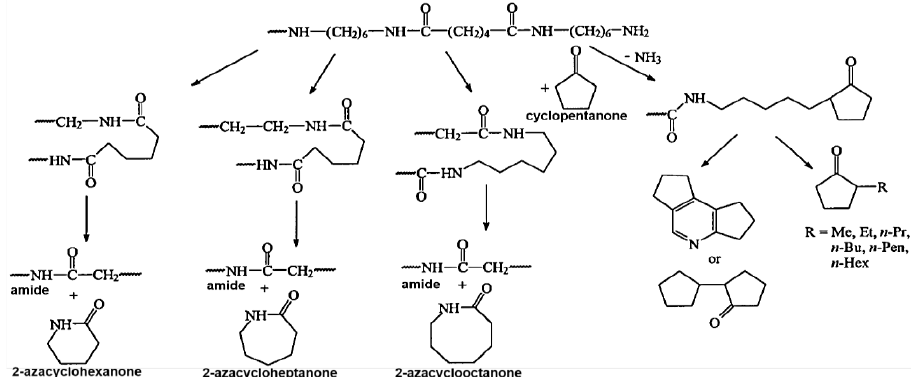
Figure 3. PA66 degradation mechanism and its byproducts (adopted from Reference [56]). Chromatograms of the PA66 pyrolysis byproducts before and after the immersion were compared using py-GC/MS. The results showed that as immersion time increased, PA66 byproducts increased as well, these included cyclopentanone (retention time (r.t.) 5m, 1 (cid:13) ), 2-N-Hexylaziridine (r.t. 8.6m, 2 (cid:13)